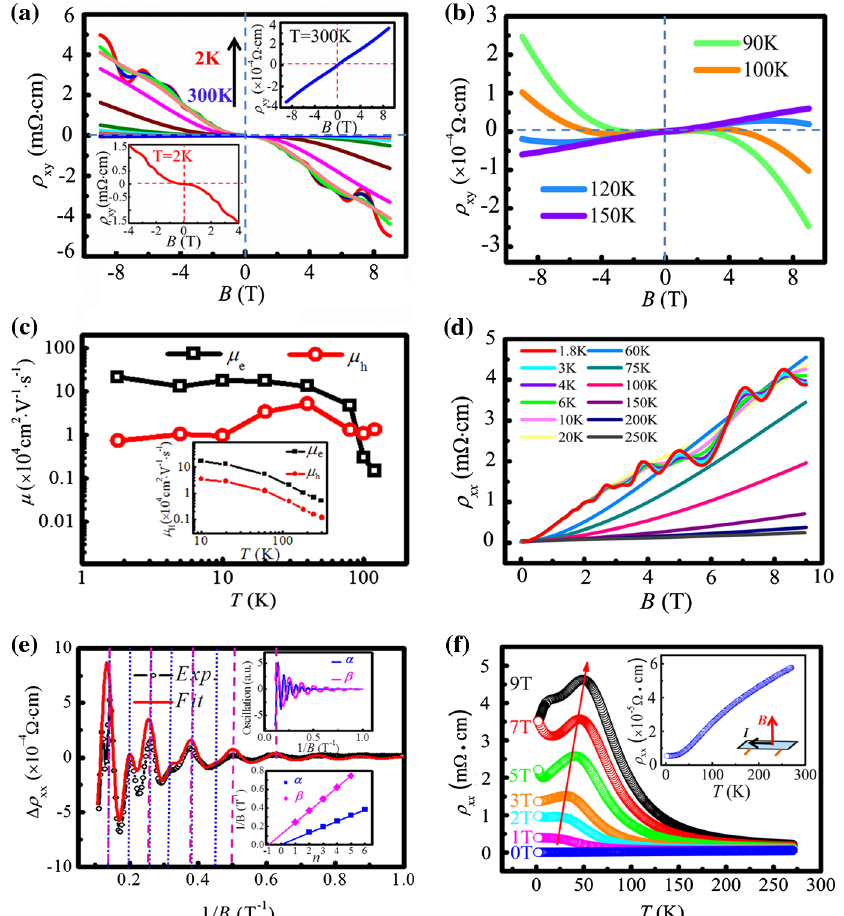
FIG. 3. Temperature dependence of Hall resistivity and resistivity for TaAs. (a) Hall resistivity measured at various temperatures from 2 to 300 K. The lower-left and the upper-right insets show the Hall resistivity at 2 and 300 K, respectively. The obvious SdH oscillation demonstrates the high quality of the sample. (b) Hall resistivity at T ¼ 90 , 100, 120, and 150 K. (c) Temperature dependence of carrier mobility μ e and μ h of electrons and holes deduced by the two-carrier model. Main panel: Fitting with σ xy ; inset: fitting with σ xx . (d) Magnetic field dependence of resistivity with θ ¼ 0 ° at representative temperatures. (e) Main panel: Oscillatory components of ρ at xx 1.8 K, obtained by subtracting the ρ at 20 K. The open circles are the experimental data, and the red line is the best fit by two xx oscillatory frequency components. Upper inset: Two frequency components α ¼ 16 T and β ¼ 7 T extracted from raw oscillation patterns in the main panel. Lower inset: Landau-level index plots 1 =B versus n for different oscillation frequencies α ¼ 16 T and β ¼ 7 T. We assigned integer indices to the Δ ρ peak positions in 1 =B and indicated them with blue and pink dashed lines in the main xx panel. (f) The temperature dependence of resistivity in the magnetic field perpendicular to the electric current. The red arrow indicates that the resistivity peak moves to high temperatures under much higher magnetic fields. The inset gives the measurement configuration and zooms in on the case of 0